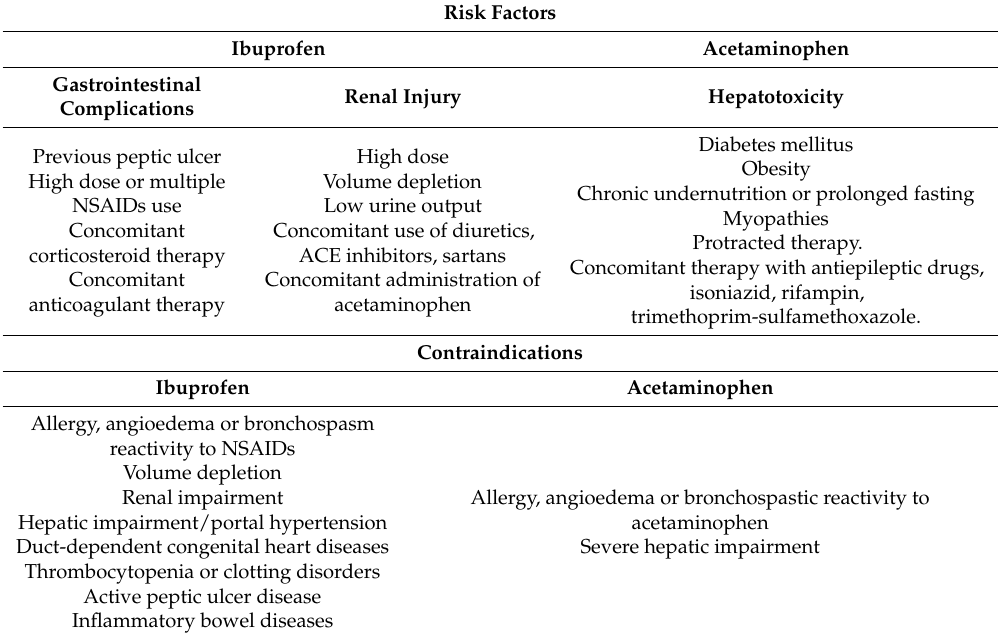
Table 2. Risk factors and contraindications for antipyretic drugs in children (from